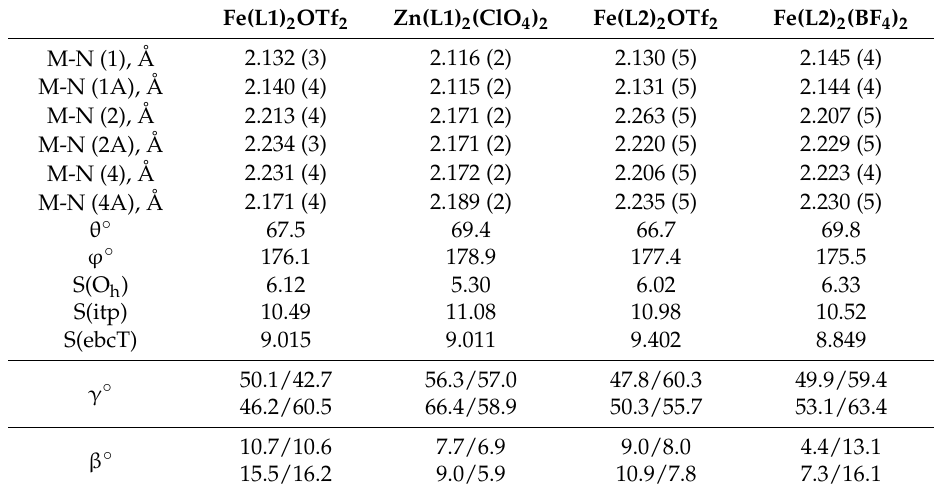
Table 1. Main geometric parameters and continuous symmetry measures as obtained by X-ray diffraction.